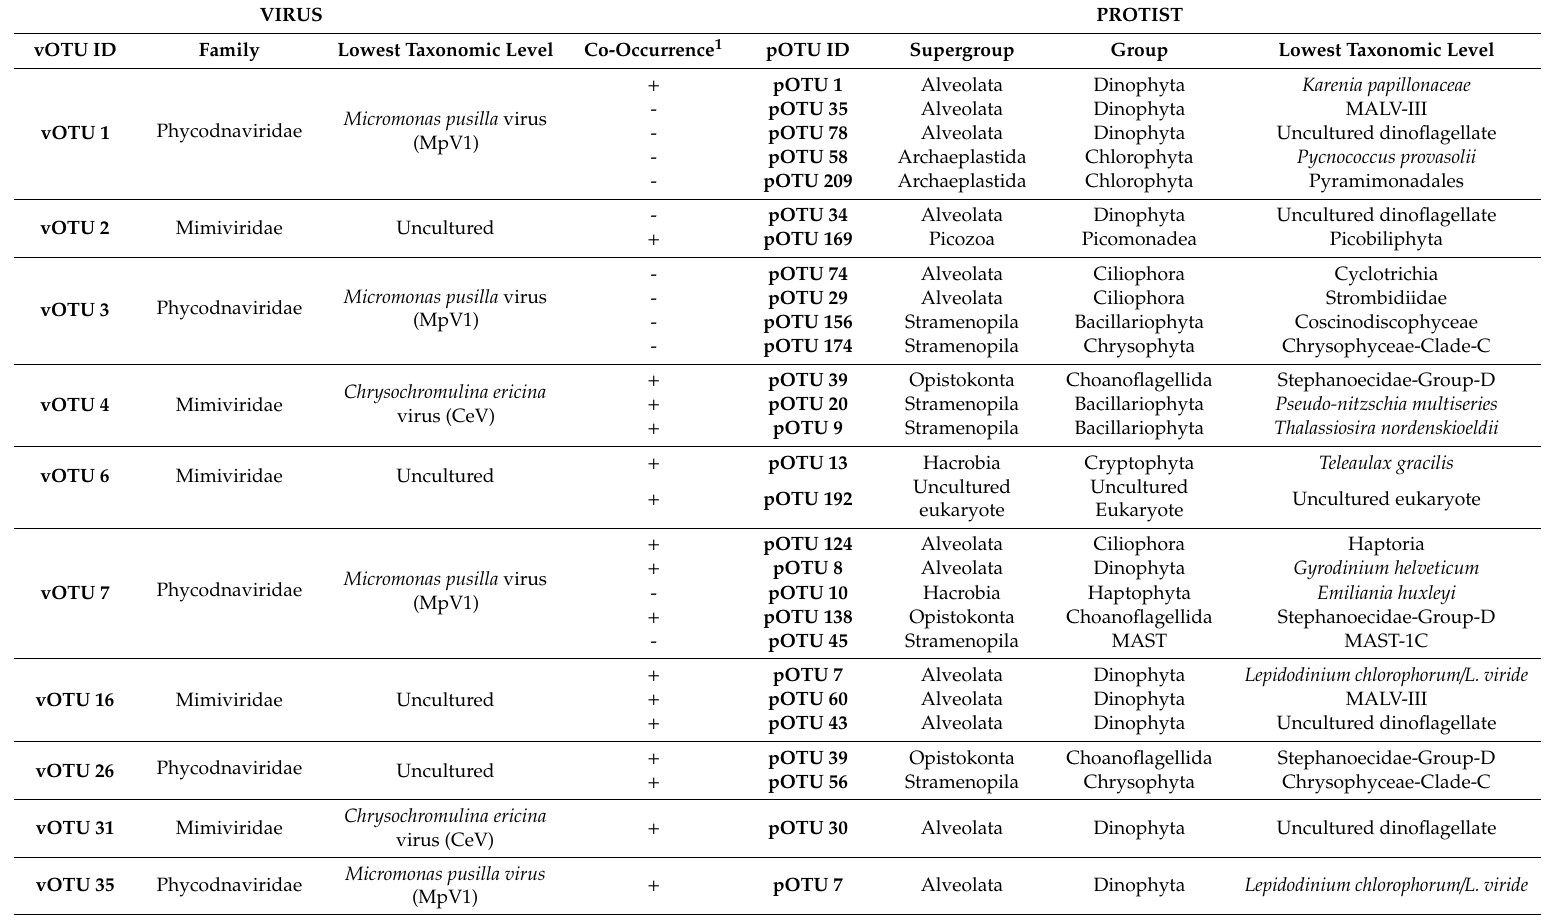
Table 1. Details on positive and negative co-occurrences between virus MCP gene OTUs (vOTUs) obtained in this study and protist 18S rRNA gene OTUs (pOTUs) obtained by Gran-Stadniczeñko et al.